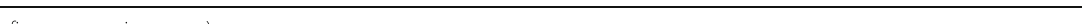
(See figure on previous page.) Fig. 2 Prognostic significance of JAK-STAT driver genes. a Heatmap illustrates hazard ratio values obtained from Cox proportional hazards regression on 40 candidate drivers across all cancer types. b Heatmap illustrates Spearman ’ s correlation coefficient values comparing hazard ratios of the 40 driver genes. Highly correlated genes are highlighted in red and are demarcated by a red box. c Box plots represent the distribution of 28-gene scores derived from highly correlated JAK-STAT driver genes. Cancers are ranked from high to low median scores. d Heatmap depicts the Z-scores for each of the 28 genes by cancer types. e Kaplan-Meier analyses confirmed prognosis of the 28-gene signature in five cancer cohorts. Patients are separated into 4th and 1st survival quartiles based on their 28-gene scores. P values are obtained from log-rank tests. f Ordination plots of multidimensional scaling analyses using signature genes reveal significant differences between tumor and non-tumor samples. P values are obtained from PERMANOVA tests. g Expression distribution of 28-gene scores in tumors stratified by stage (s1, s2, s3 and s4). P values